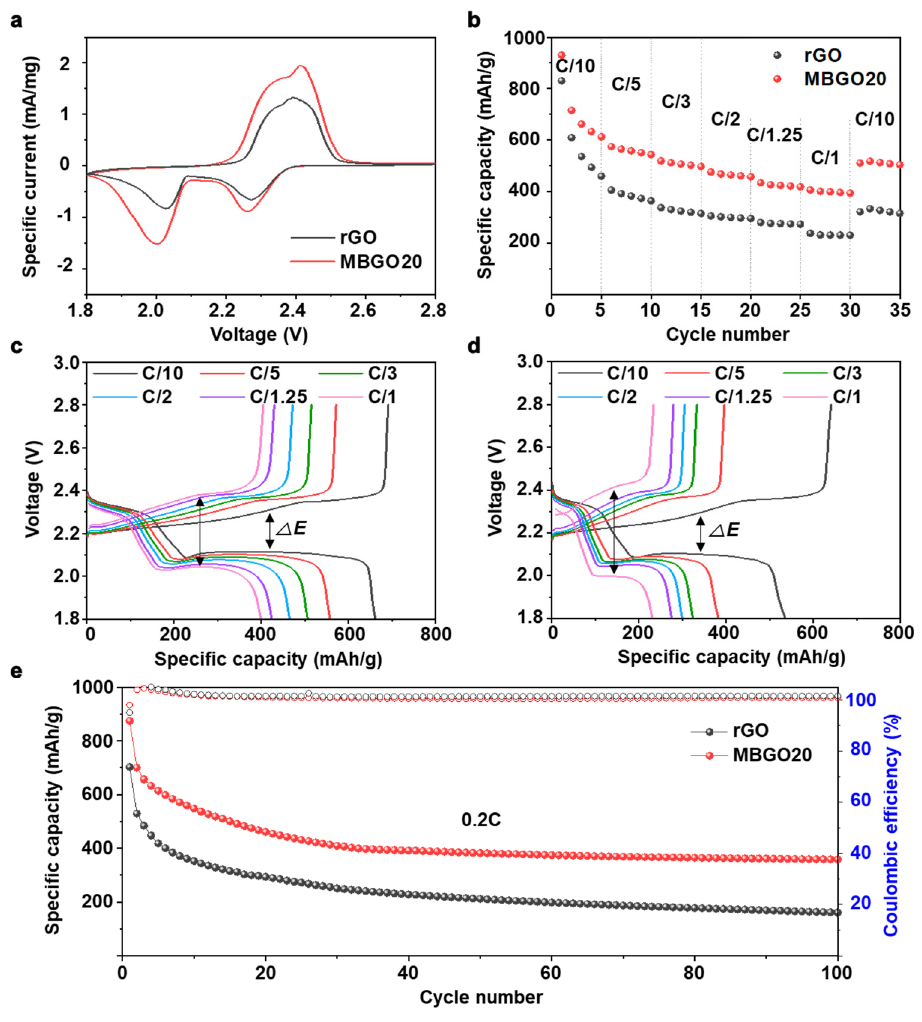
Figure 3. ( a ) CV curve of MBGO20 and rGO cells at 0.1 mV/s in the voltage window of 1.8 to 2.8 V. ( b ) Rate capability and galvanostatic charge–discharge profiles of ( c ) MBGO20 and ( d ) rGO cells at various current rates. ( e ) Cycling performance and Coulombic efficiency at 0.2 C.